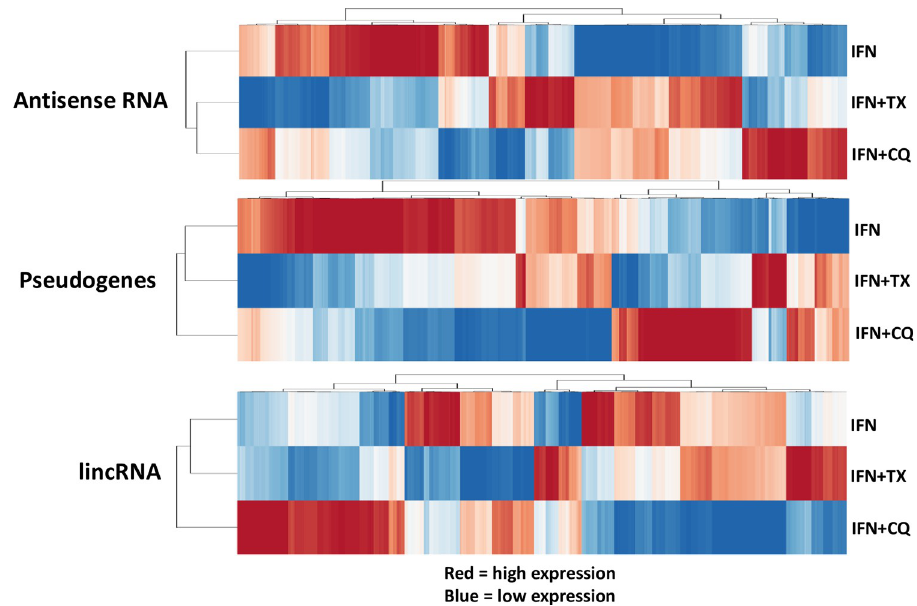
Fig 3. Heatmaps illustrating changes in antisense RNA, pseudogenes, and lincRNA due to MIAMI cells’ exposure to interferon gamma (IFN γ ) alone or in combination with chloroquine (CQ) or Tamoxifen (TX).